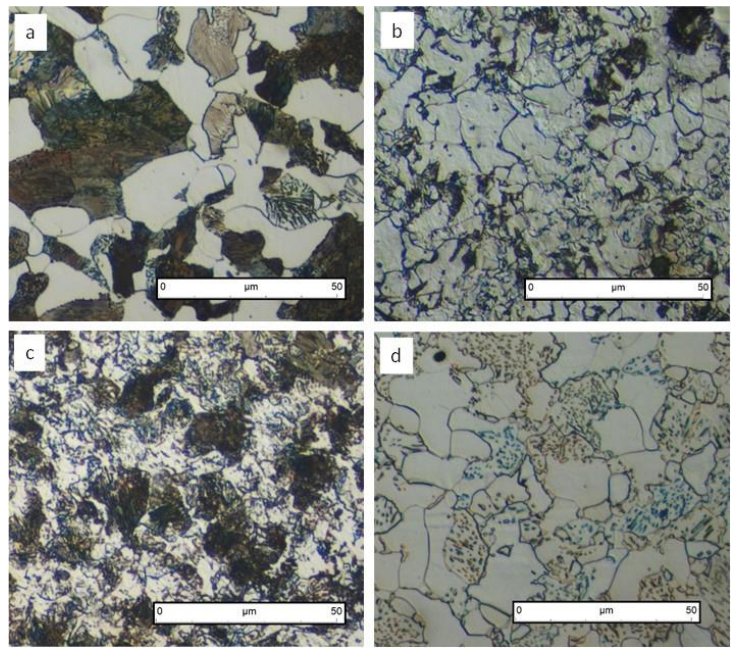
Figure 1. Typical annealing microstructures of a C45E steel ( a ), a C22E steel ( b ) and a 34CrMo4 steel ( c ); globular annealing of C45E steel ( d ).